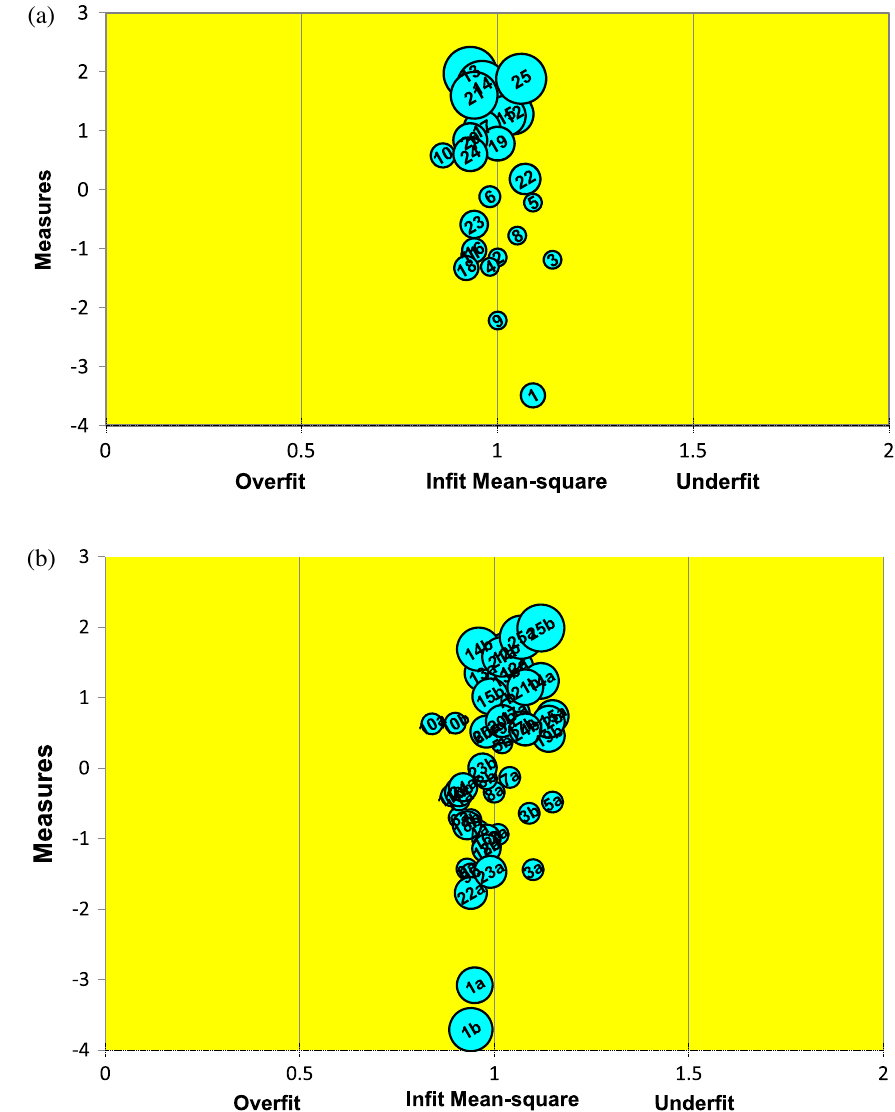
FIG. 8. (a) Bubble-chart for MNSQ Infit values for paired scoring. (b) Bubble-chart for MNSQ Infit values for separate